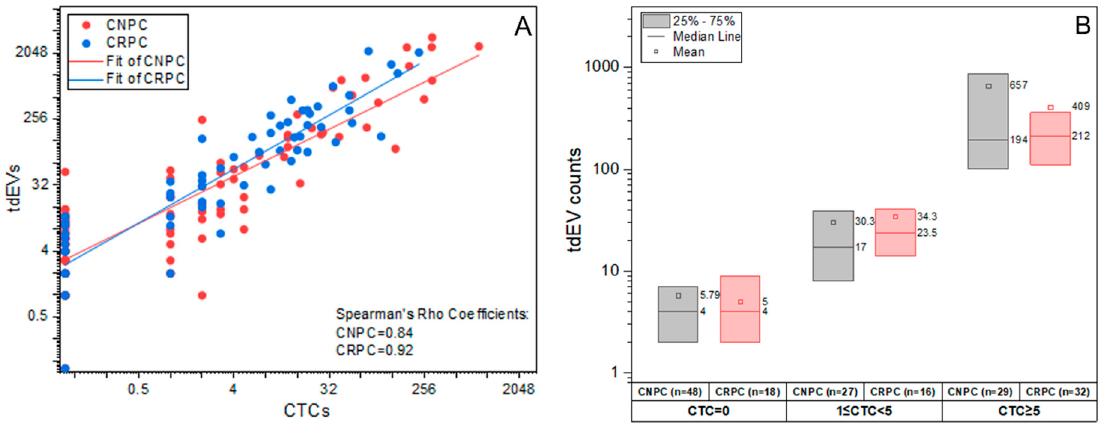
Figure 2. Correlation of CTCs (CTC ACCEPT corrected) and corresponding tdEVs from CNPC (n = 104) and CRPC (n = 66) patients, prior to initiation of therapy. (A): CTCs and tdEVs were strongly correlated (Spearman Rho coefficients ρ = 0.84 in CNPC, ρ = 0.92 in CRPC) and this correlation was independent of the disease stage. (B): tdEVs within the categories CTC = 0 (CNPC, CRPC median = 4, p = 0.937), 1 ≤ CTC < 5 (median CNPC = 17, CRPC = 23.5, p = 0.3) and CTC ≥ 5 (median CNPC = 194, CRPC = 212, p = 0.806) showed no significant difference between CNPC and CRPC.